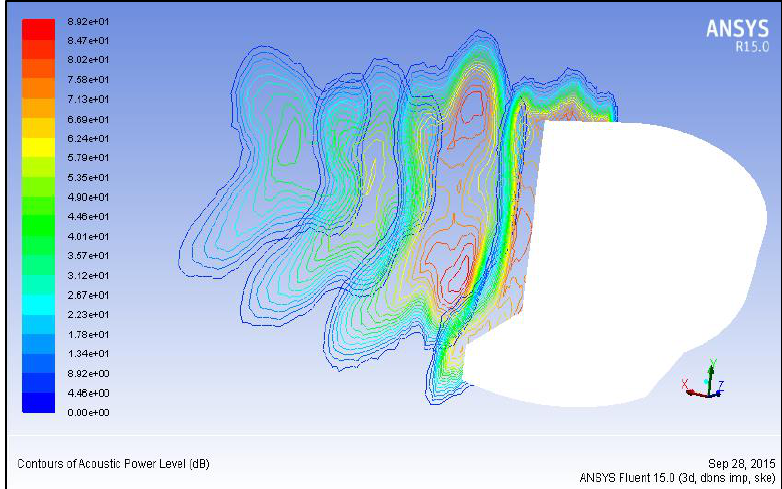
Figure 8. Sound pressure level in Z-direction (120 km/h)